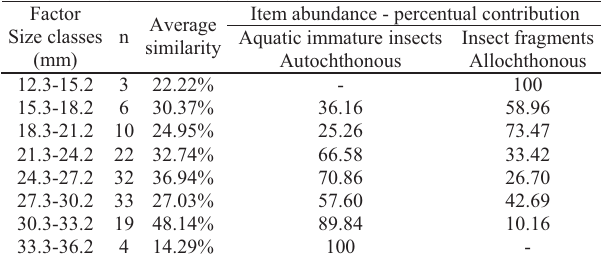
Table 3. SIMPER results, showing the contribution percentages of the most representative item abundance for each size class considered.